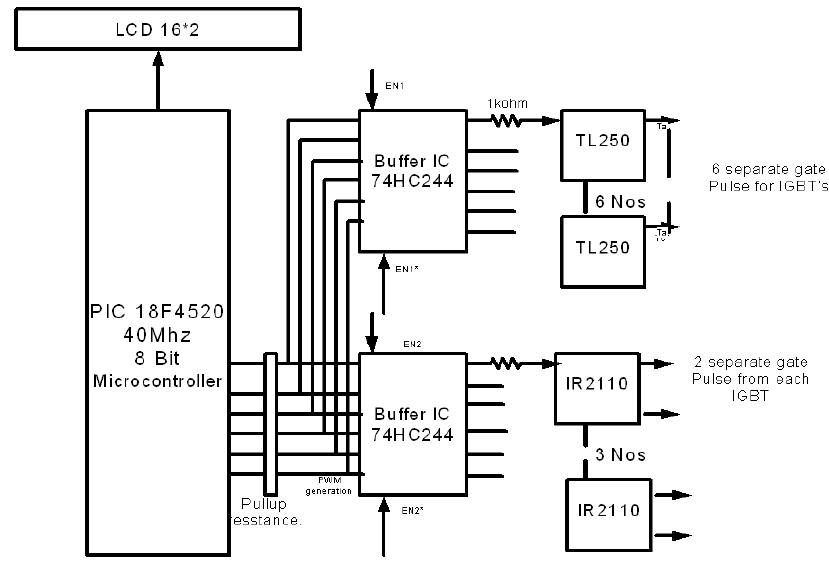
Figure 30. Hardware implementation.